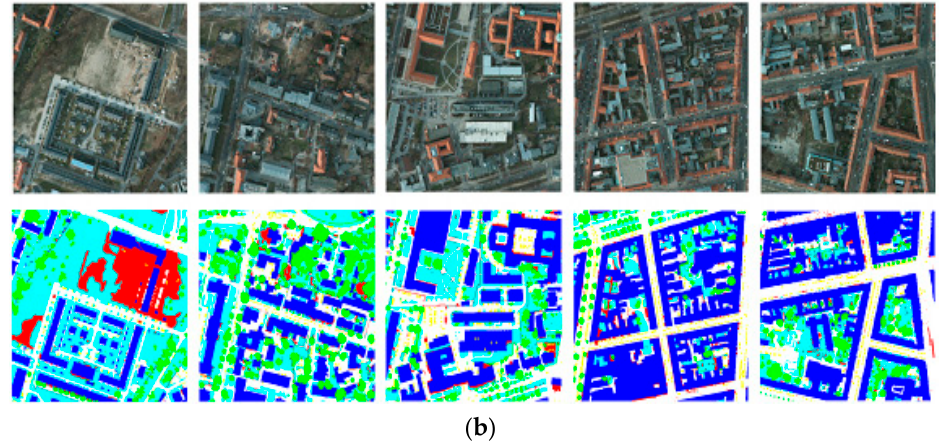
Figure 5. Two open standard datasets used: ( a ) Inria Aerial Image Labeling Dataset; ( b ) ISPRS Potsdam semantic labeling dataset. Table 2. The number of samples for training, validating, and testing from the two standard